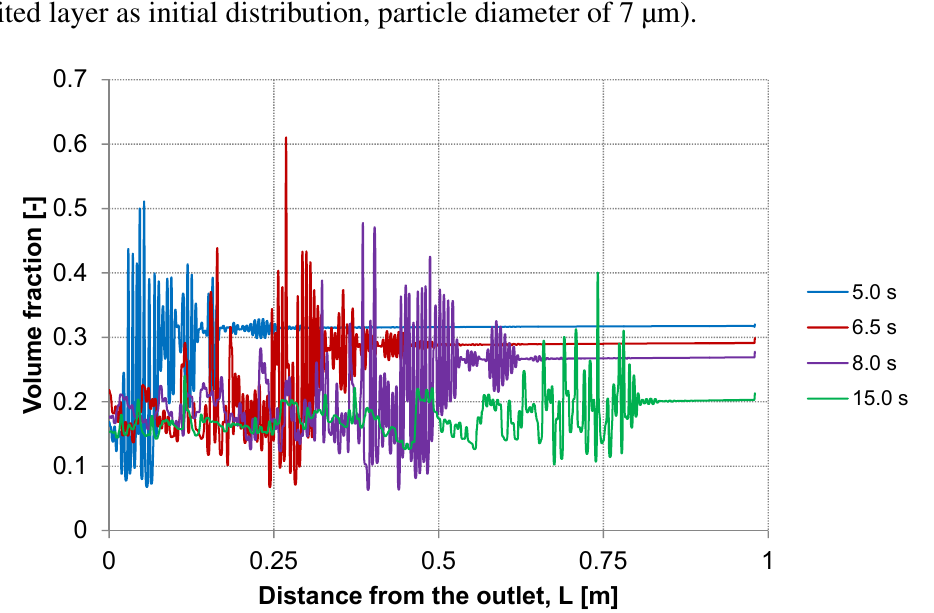
Figure 9. Particle distribution at control line D with backwashing flux of 300 L m − 2 h − 1 , (deposited layer as initial distribution, particle diameter of 7